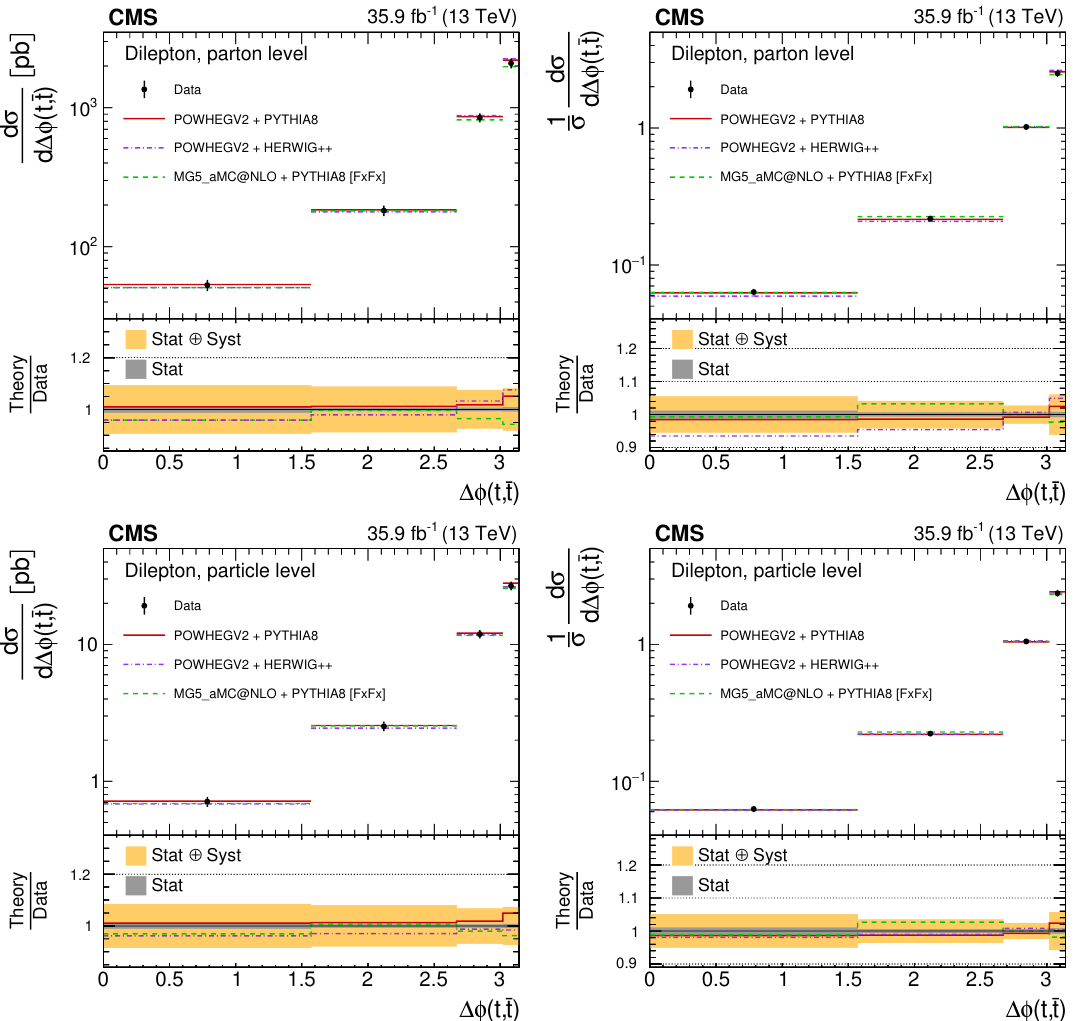
Figure 23 . The di(cid:11)erential tt production cross sections as a function of (cid:1) (cid:30) (t ; t) are shown for the data (points) and the MC predictions (lines). The vertical lines on the points indicate the total uncertainty in the data. The left and right columns correspond to absolute and normalised measurements, respectively. The upper row corresponds to measurements at the parton level in the full phase space and the lower row to the particle level in a (cid:12)ducial phase space. The lower panel in each plot shows the ratios of the theoretical predictions to the data. The dark and light bands show the relative statistical and total uncertainties in the data, respectively.